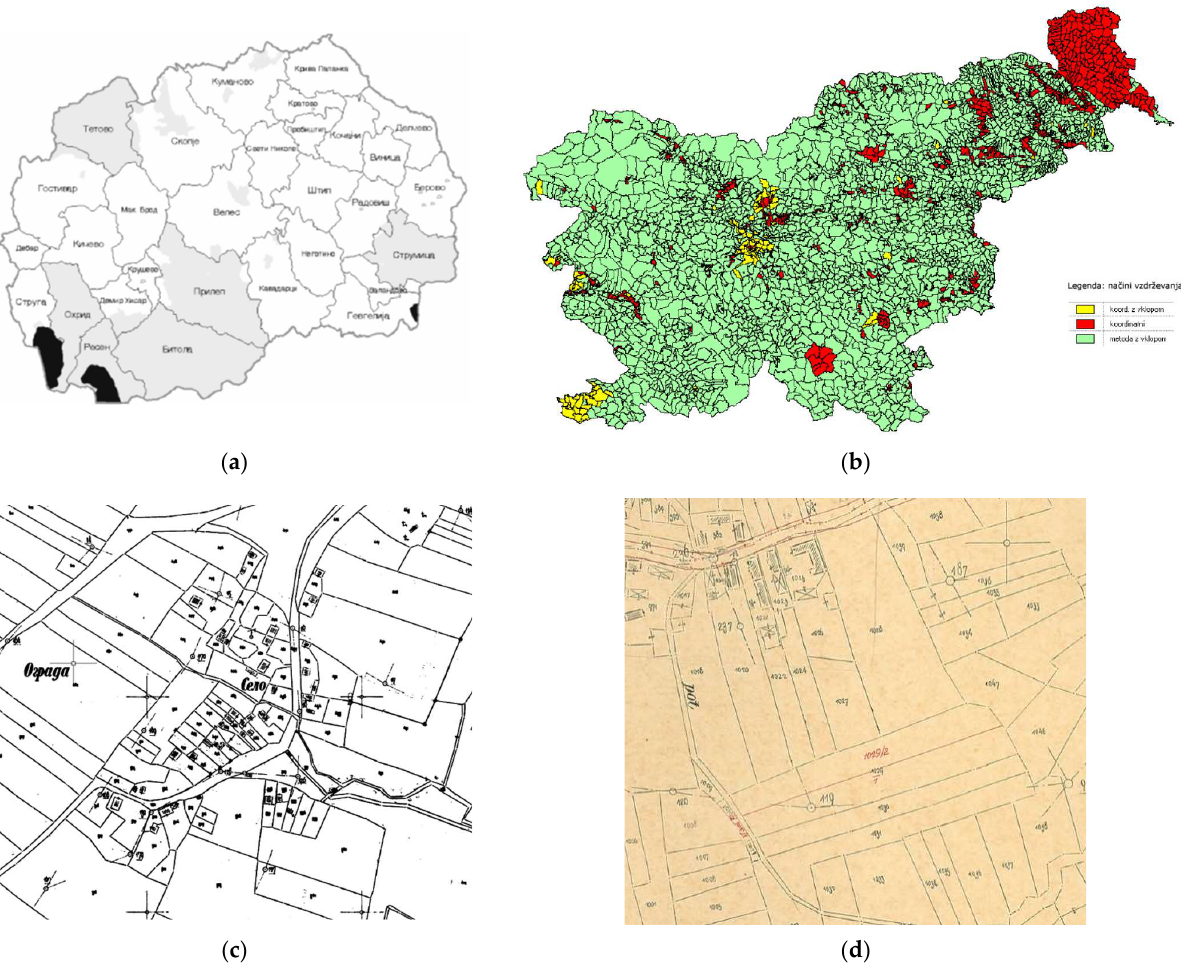
Figure 2. Regions with measurement-based cadastral survey including surveying field books; ( a ) Cadastral survey in North Macedonia in the period 1928–1945 (grey) [36]. ( b ) Cadastral survey in Slovenia in the period 1945–1974 and in the period 1975–2005 (red and yellow) [37]; ( c ) Example of archived/initial cadastral map at 1:2500 scale; ( d ) Example of working cadastral map at 1:2500 scale.